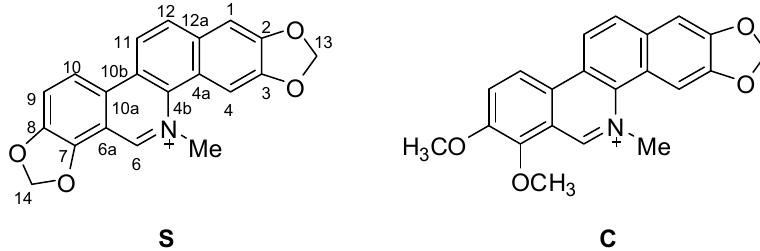
Figure 1. Structures of sanguinarine ( S ) and chelerythrine ( C